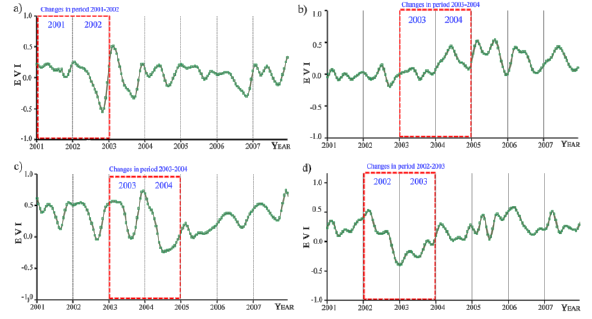
Figure 5. Several detected changes from a single MODIS pixel that assigned as the actual changes LUCC